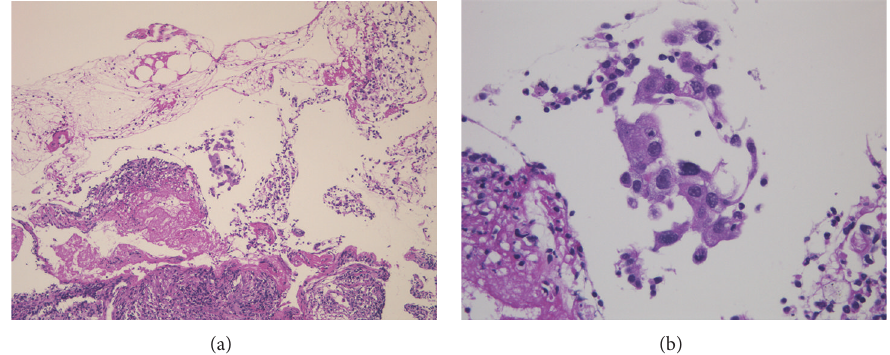
Figure2: Pathological examination of biopsyspecimens revealing squamouscell carcinoma (hematoxylin andeosin staining).(a)Low-power magnification and (b) high-power magnification.